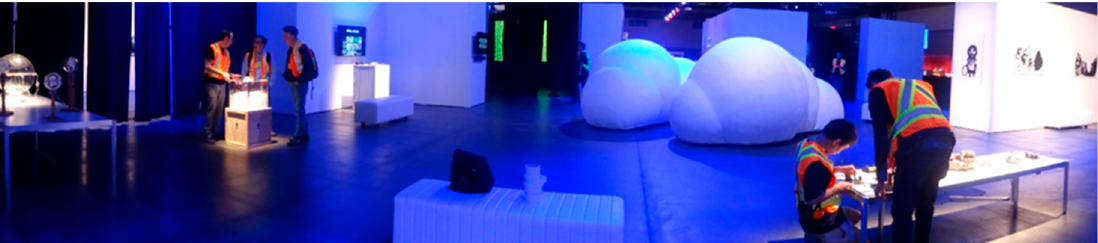
Figure 1. SIGGRAPH 2018 Art Gallery, setup process. Used by permission of Milton Sogabe. Photograph by Milton Sogabe.